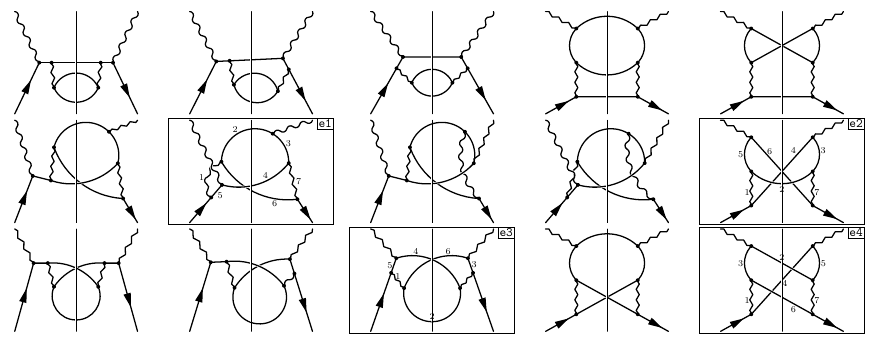
Figure 6. Diagrams contributing to the total cross section of the e − γ → e − e − e +